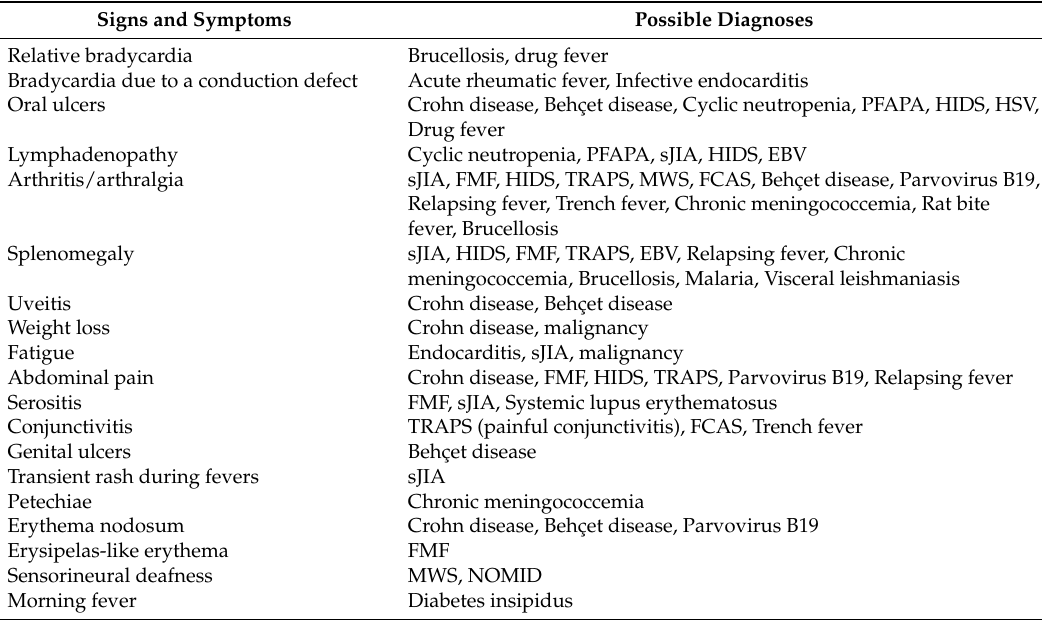
Table 3. Signs and symptoms suggestive of a specific